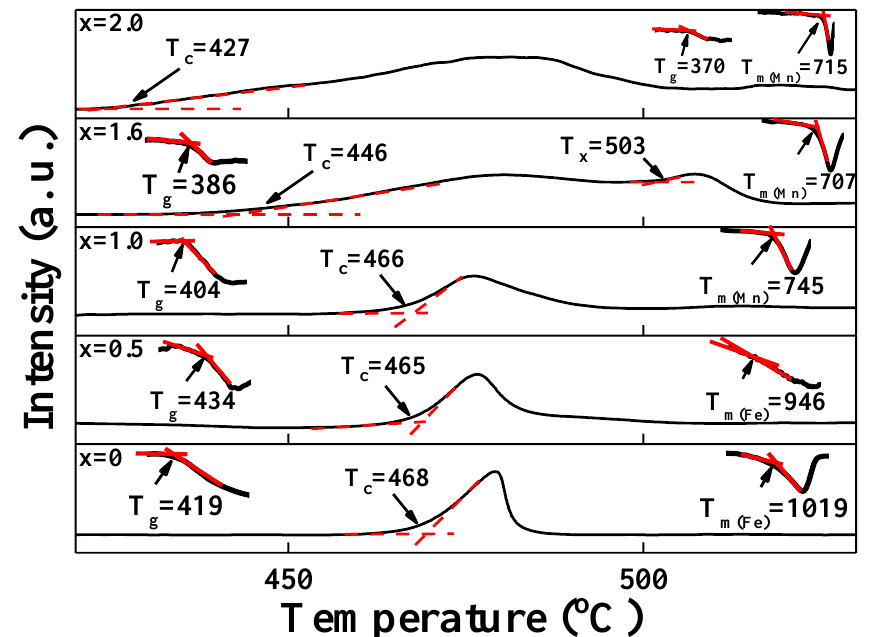
Figure 3. Selected DTA curves for 3Li 2 O-(2-x)Fe 2 O 3 –xMn 2 O 3 -3P 2 O 5 (x = 0, 0.5, 1.0, 1.6, 2.0) glasses, measured at a heating rate of 10 ◦ C/min. The glass transition temperature is denoted as T g , the onset crystallization temperature as T c , and the onset melting temperature as T m . T x is related to the relaxation temperature of crystallization and/or